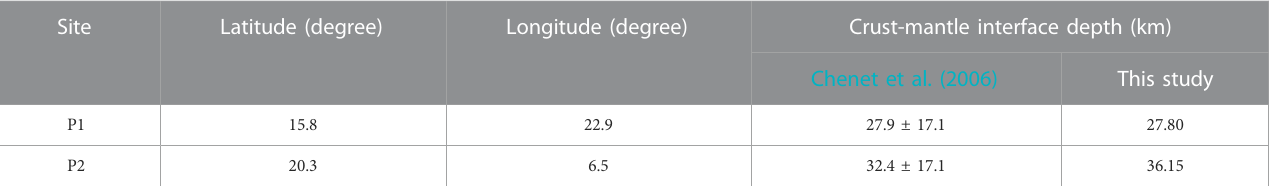
TABLE 2 Crust-mantle interface depth comparison from various researches in the mare